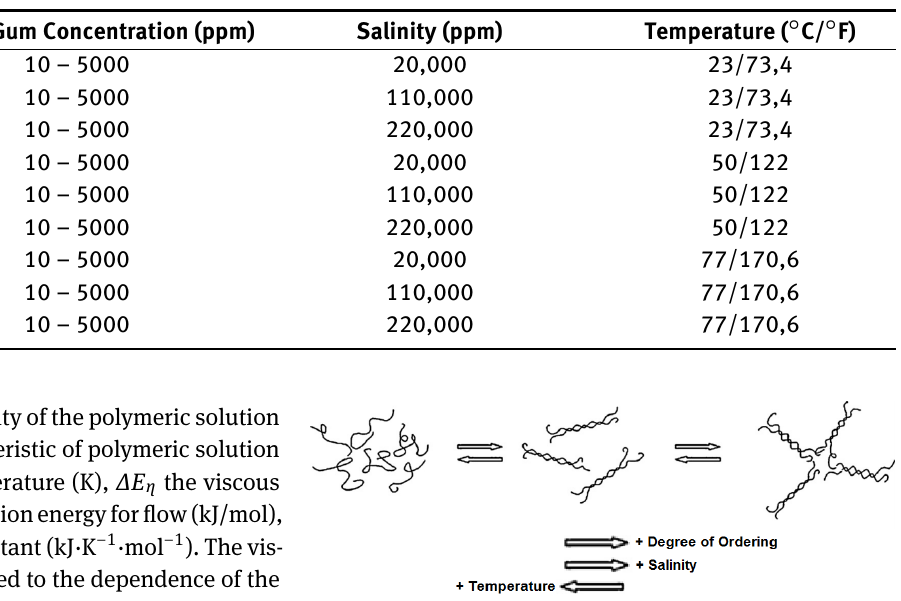
Table 1: Experimental conditions for rheological tests